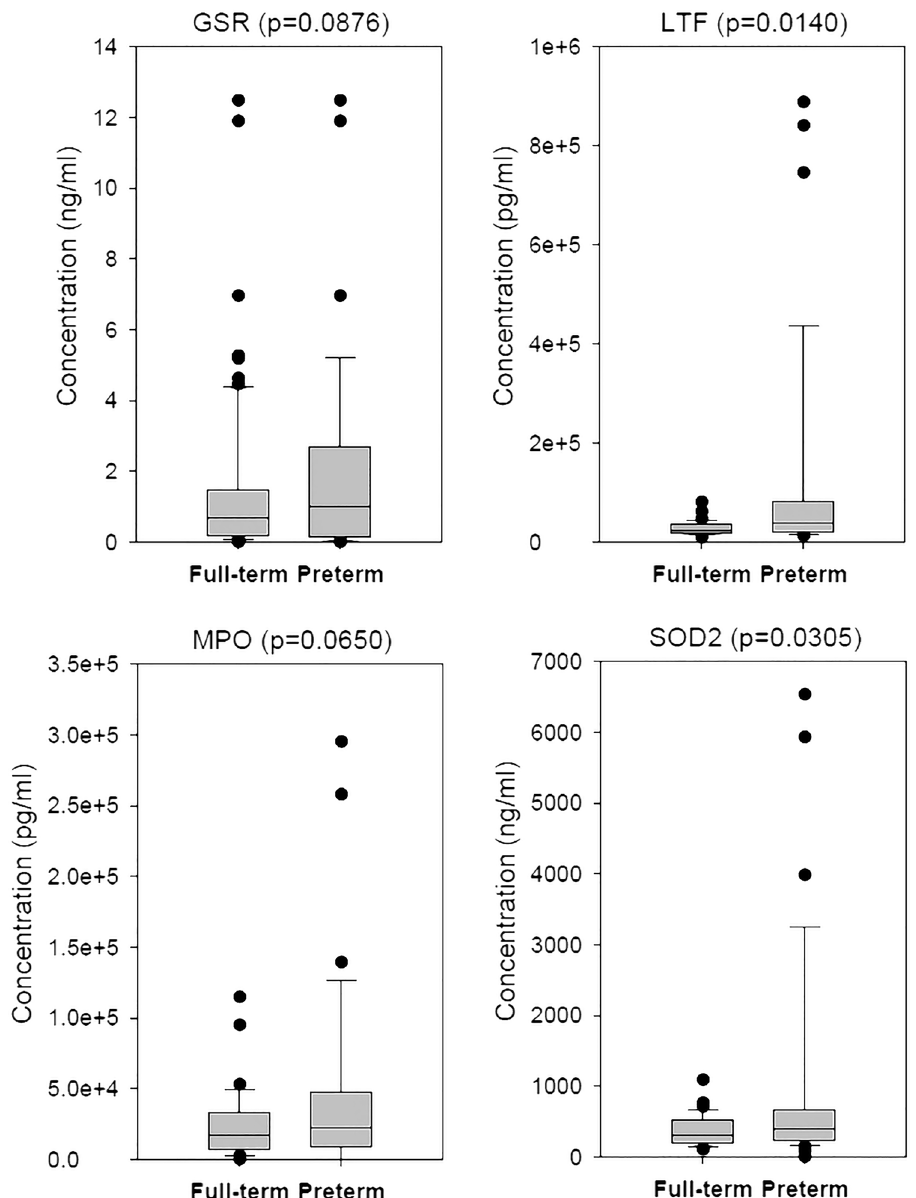
Figure 3. The ELISA results for specific proteins. We used ELISA to validate six candidate proteins screened by mass spectrum data and used box plots to illustrate the concentrations of four proteins.